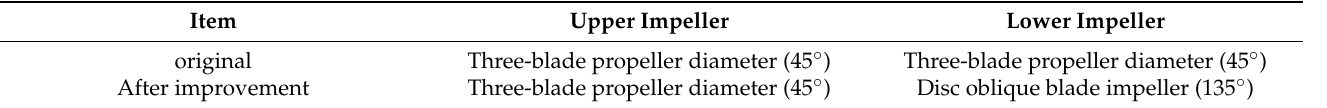
Table 2. Type of double-layer impeller.